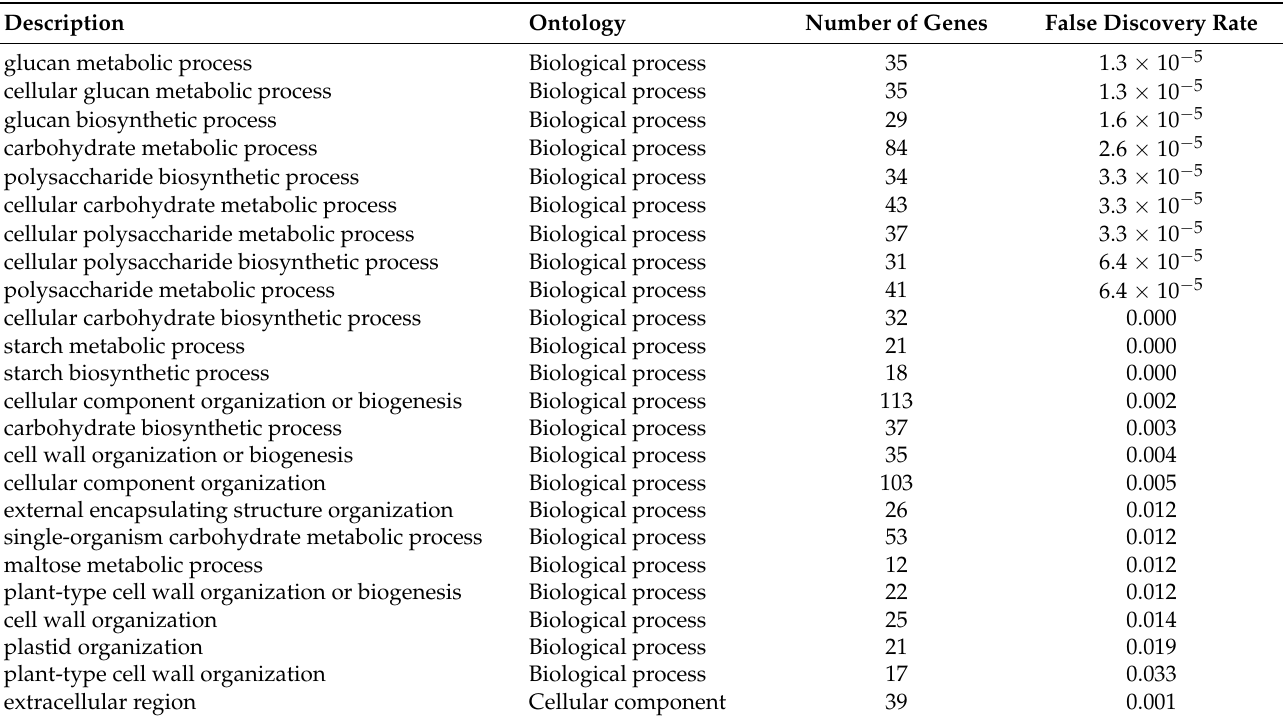
Table 2. Gene Ontology (GO) terms enriched in BM13H during infection by B. rouxiae